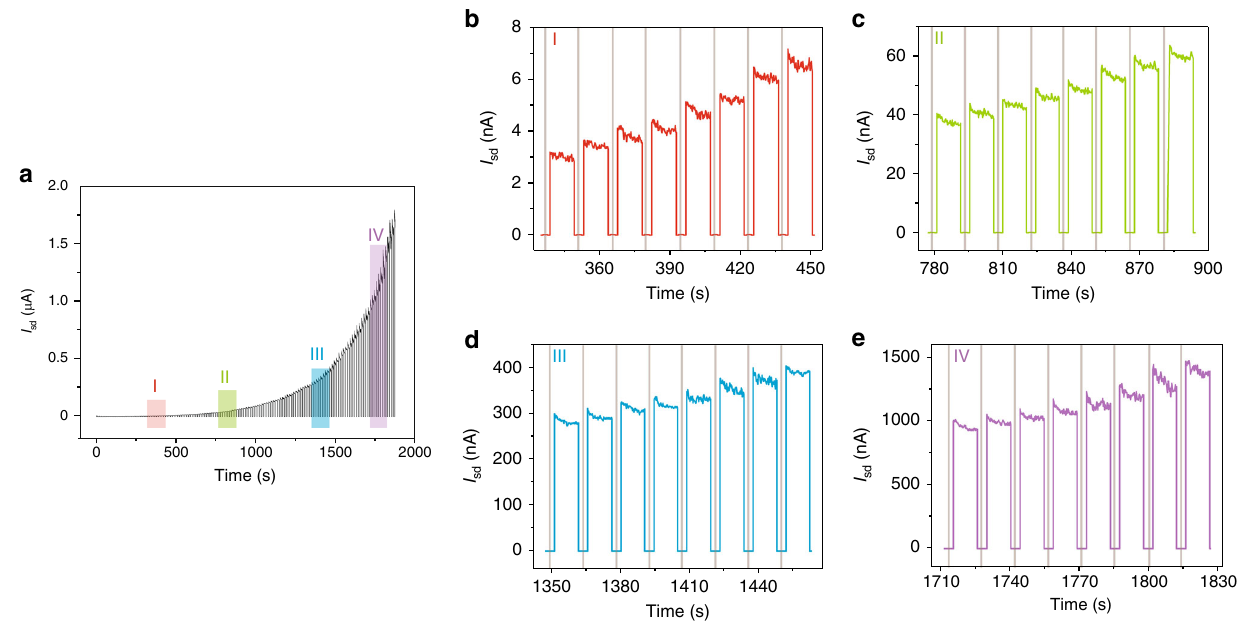
Fig. 3 One hundred thirty storage states. a The dynamic behavior of the memory under the exposure of light pulse ( t pro = 0.5 s, λ = 405 nm, P = 2 nW) at V = − 80 V, and the enlargements in region I ( b ), II ( c ), III ( d ), and IV ( e ), respectively. The regions shaded in red, green, blue, and purple in a correspond pro to the enlarged regions plotted in the same colors in b – e ,